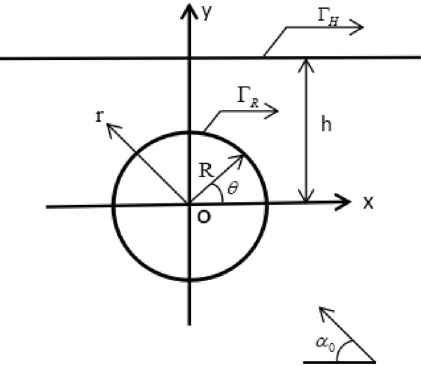
Figure 1. Semi-space model with a circular